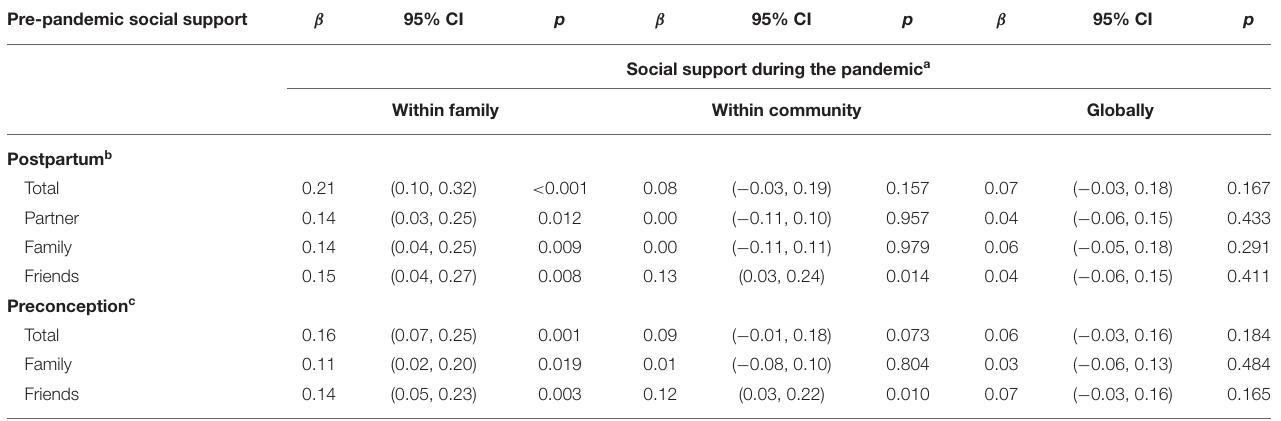
TABLE 3 | Adjusted associations between pre-pandemic social support and social support during the COVID-19 pandemic. Pre-pandemic social support